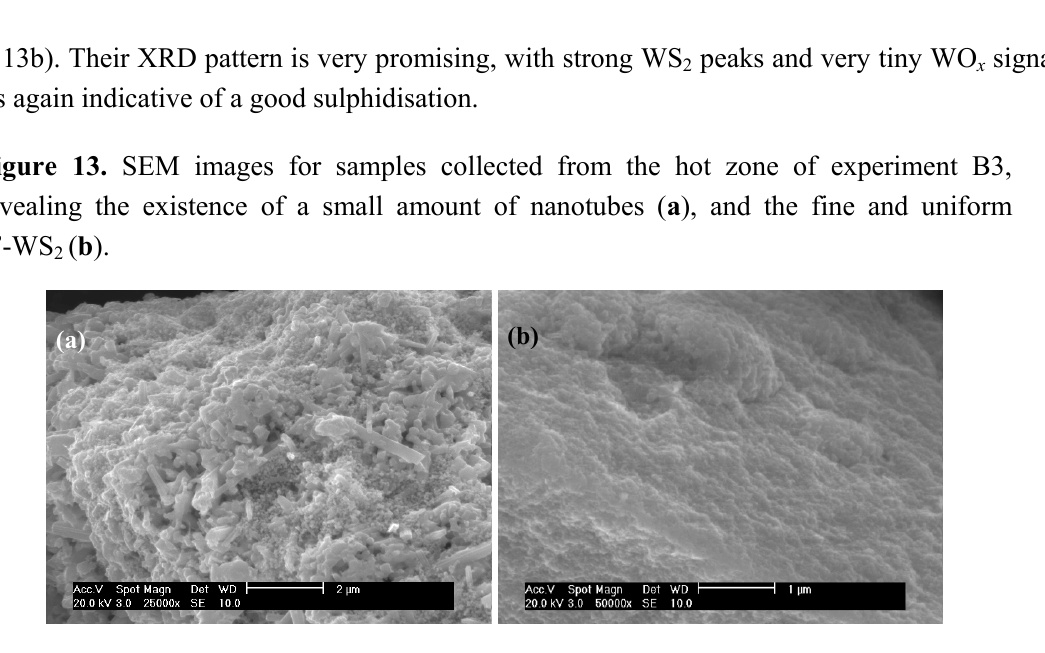
Figure 14. TEM images for samples collected from the hot zone of experiment B3, demonstrating the overall distribution of particle ( a ) and the multi-layered characteristics of different particles ( b – d